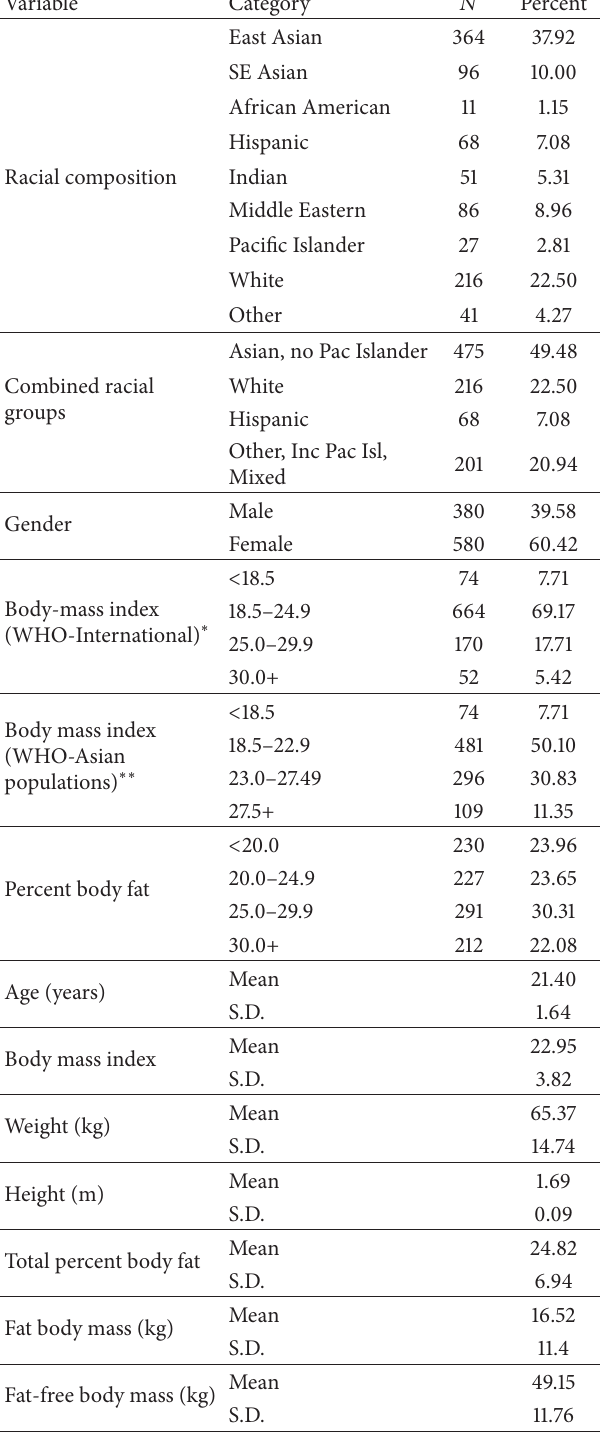
Table 1: Characteristics of the study